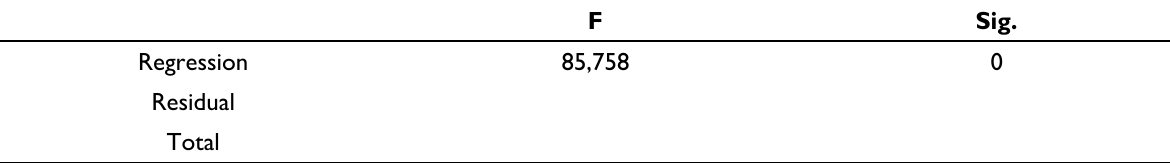
Table I. F Statistical Test